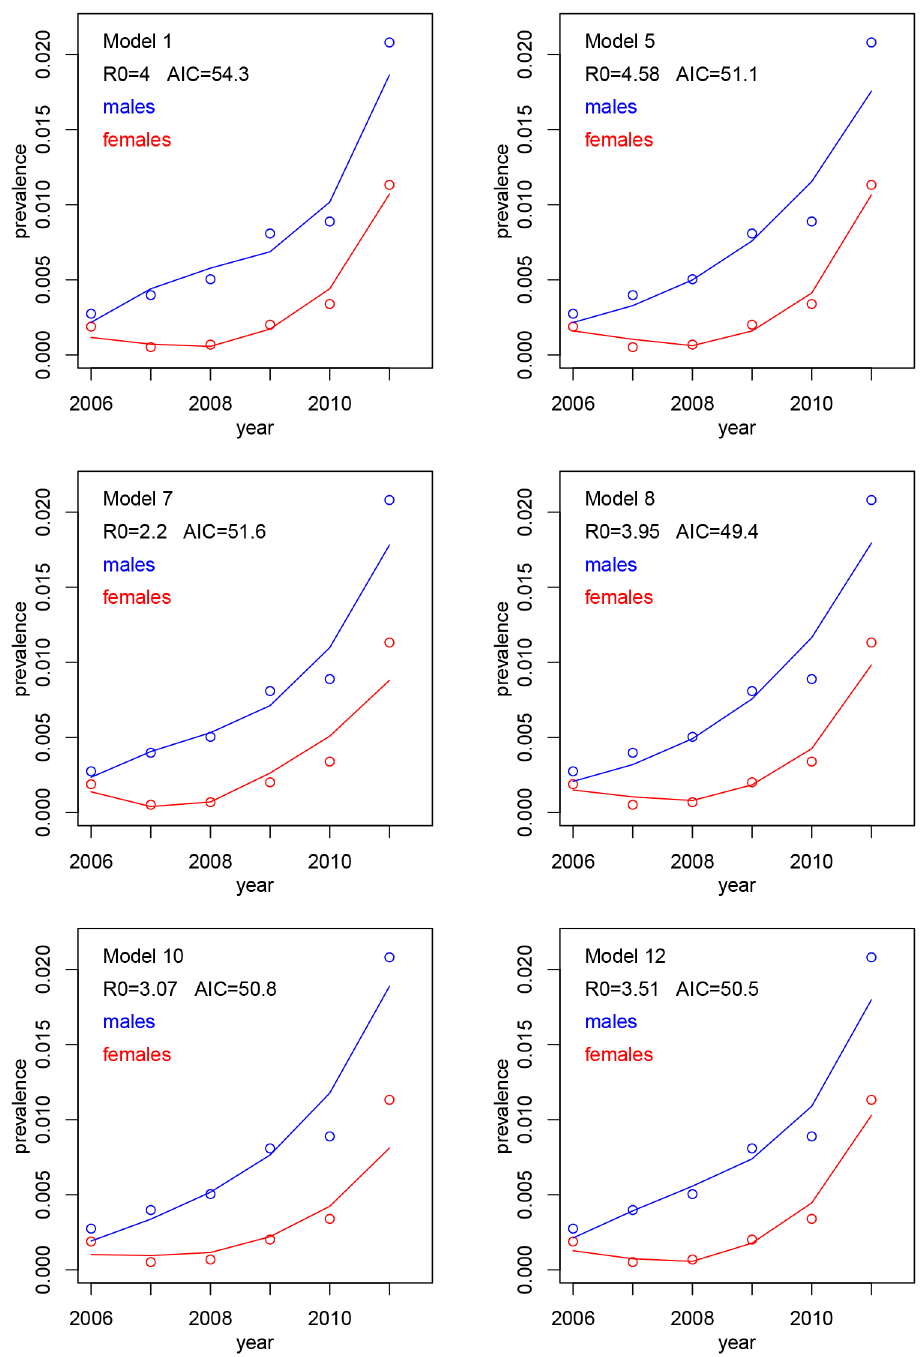
Fig 1. Circles show CWD prevalence in Alberta from hunter-harvest data in Table 1. Solid lines show Eqs (12) and (13) fit to the data. Various models correspond to different hypotheses about “ fecundity ” matrix F and are explained in Table